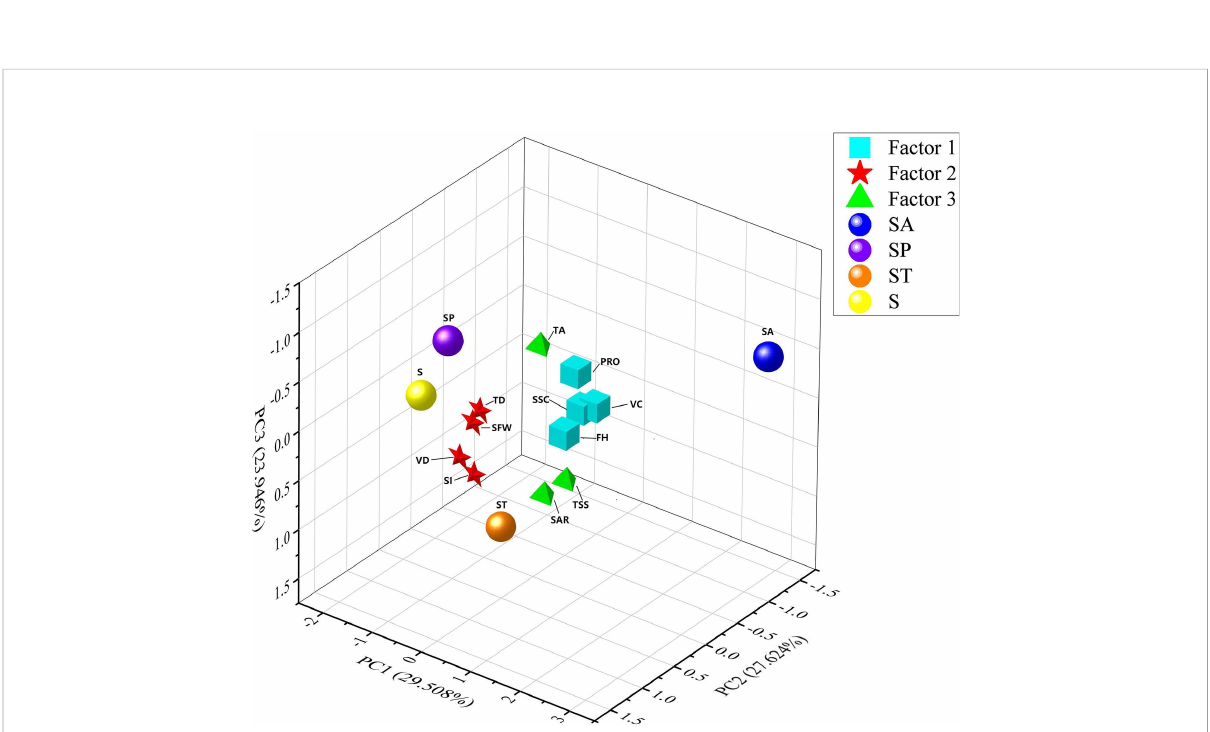
FIGURE 2 Three-dimensional scattering point diagram of factor composition and sample scores. The cube, star and tetrahedron represent PC1, PC2 and PC3,